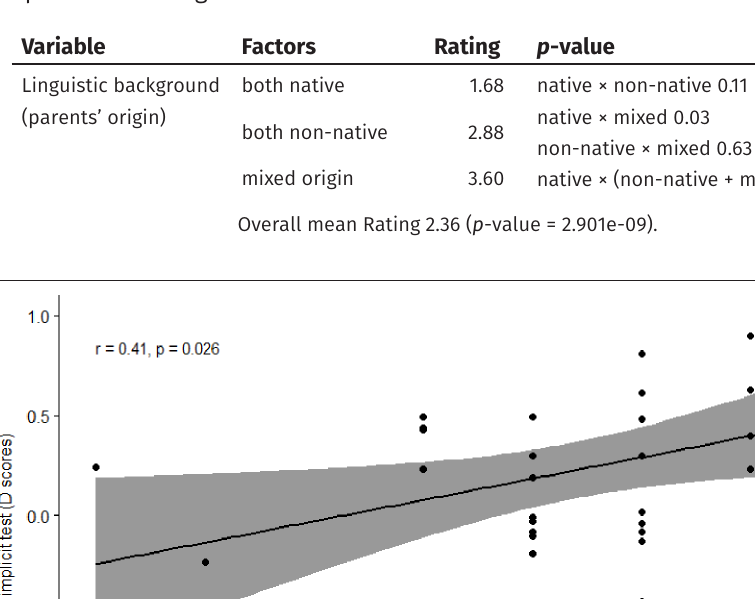
Table 4: Explicit task ratings.